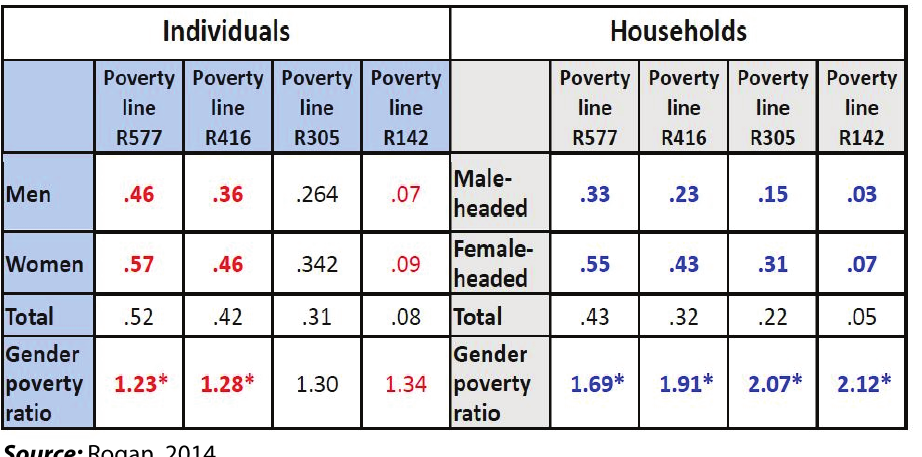
Table 3: Differences in poverty on household gender